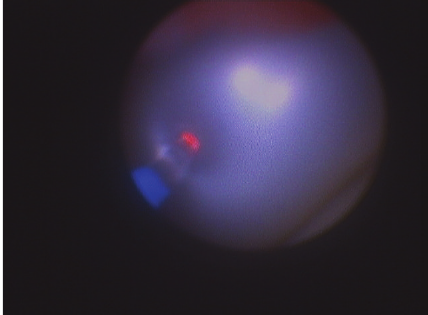
Figure4:LaserfibreusedtoburstFoleyballoontofacilitateremoval of catheter from the